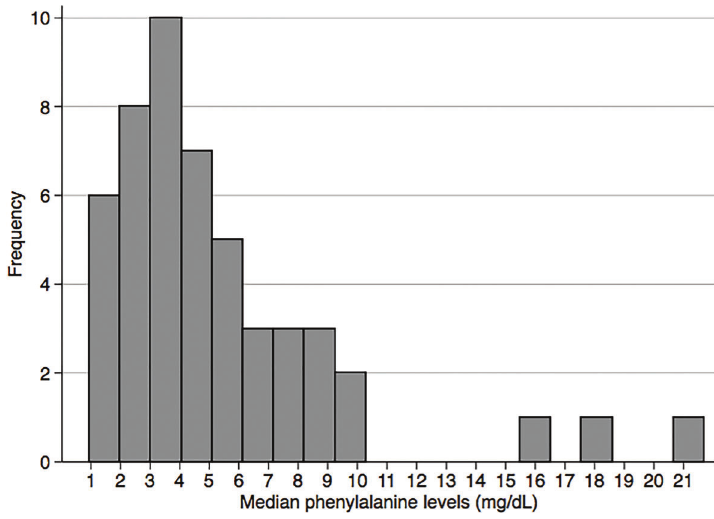
Figure 1. Median phenylalanine levels in the fi rst year of life of Brazilian early-treated PKU pediatric patients. Thirty percent of the patients had median phenylalanine levels in the fi rst year of life above the upper limit of the recommended target range for this age (6 mg/dL). PKU: phenyl-